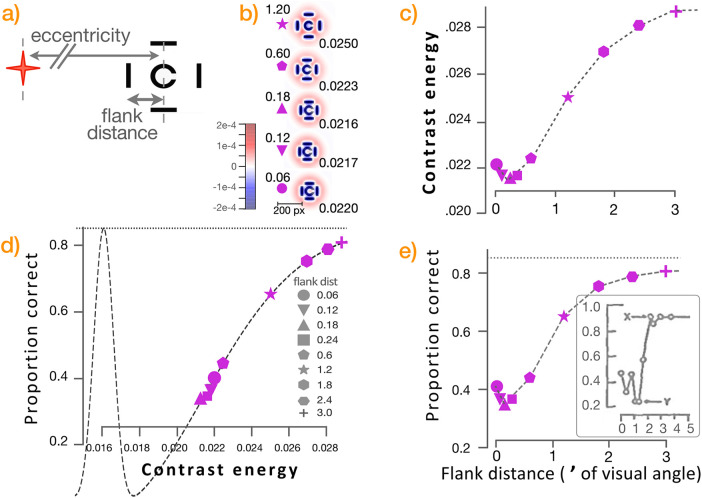
(a) Flanking bars at different distances from a target Landolt C (all at fixed eccentricity of 3 degrees of visual angle from the fixation point); the task was to identify the angle of rotation of the C. (b) Heat maps of selected images with flanks at particular distances (left side), corresponding to the x-axis of (c) and (e), exhibiting particular contrast energies (right side), corresponding to y-axis of graph (c). At flank distance 1.2′, separations can be seen (red color) between flanks and target, whereas closer flanks interact with the target. (c) The contrast energy semi-norm (Equation 4) is computed from a range of flank distances (at fixed eccentricity). At extremely small flank distance (0.06′, measured in minutes of visual angle, or units of 1/60 of a degree of visual angle), the computed contrast is relatively low (roughly 0.220). As flank distances slightly increase, contrast energy decreases (to a minimum of roughly 0.0216). Beyond this sweet spot (see Figure 3a), contrast energy monotonically increases as flankers recede from the target object, reaching an asymptotic contrast value of about 0.29 when flank objects are about 3′ distant from the target object. (d) From the flank-distance-dependent contrast values, the mapping function (Equation 5) calculates the estimated proportion of correct identifications. At lower contrast values, the effects of contrast differences are steep; that is, slight changes to contrast can substantially change estimated target identification. At higher contrasts, there is little effect. The subtly non-monotonic nature of the contrast effect can be seen. Flank distance of 0.06′ yields roughly a 41% estimated correct identification rate, but further increasing the flank distance (to 0.12′, 0.18′, and then 0.24′) causes a reduction in contrast and in identification rates. Increasing flank distance further still (to 0.6′ and above) increases contrast and correspondingly increases the rate of correct object identification (see Figures 3a and 3d). (e) Combining (c) and (d), the ability to identify a target is shown as a function of flank distance, arising solely as a function of the effects of flank distance on contrast, as in part (c). The inset in (e) shows results from the original experiment of Flom et al. (1963); shown are flank distances in minutes of visual angle and proportion of correct answers. The mark “x” denotes the maximum flanker separation at which effects of flankers affecting identification (i.e., crowding) are seen; “y” denotes the flank distance producing maximum crowding (Flom et al. 1963).